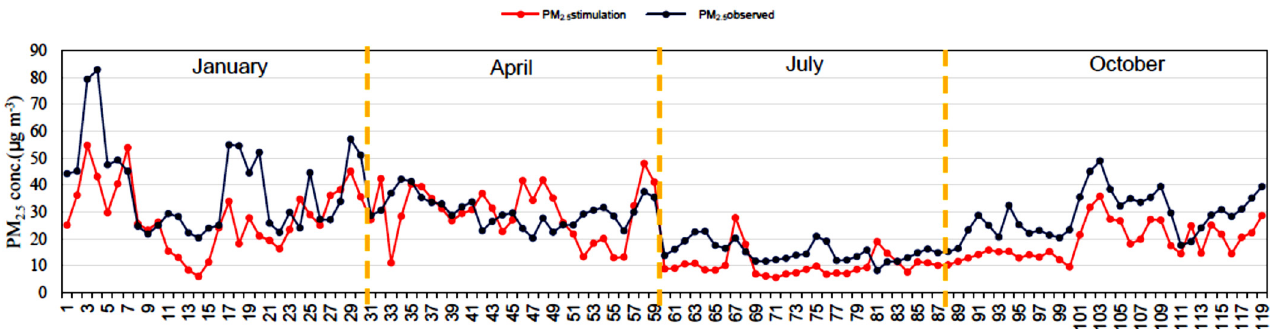
Figure 6. The modeling simulation of PM 2.5 concentrations ( μ g m − 3 ) of the ambient air quality monitoring stations.